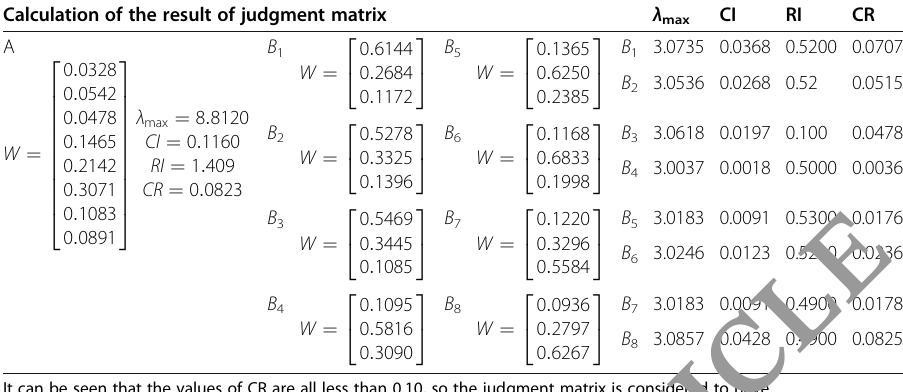
Table 1 Results of the AHP judgment matrix Calculation of the result of judgment matrix λ max